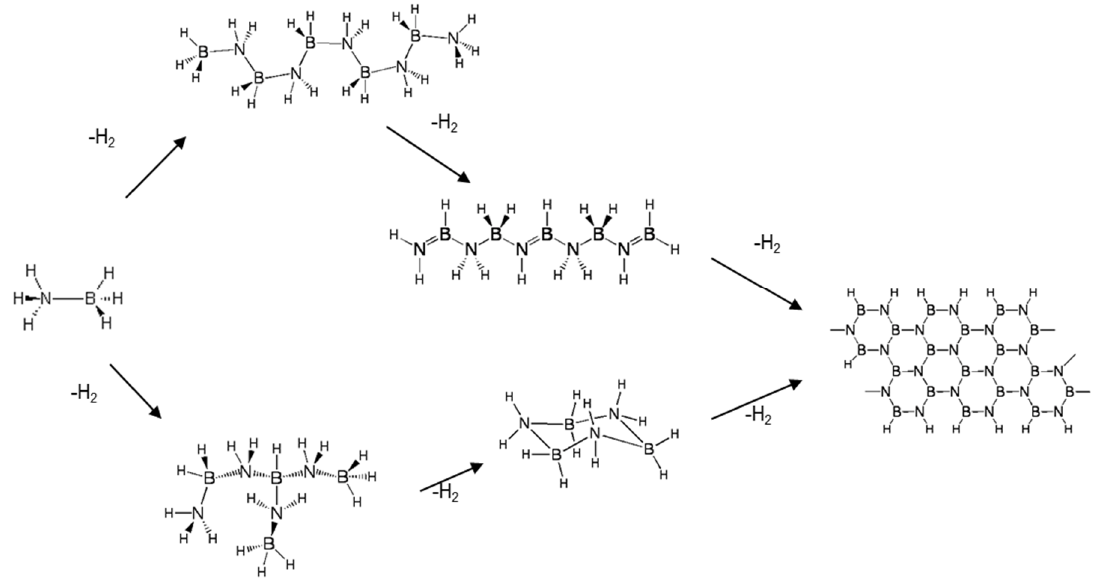
Figure 4. Reaction pathways and products observed during the thermal decomposition of solid-phase ammonia borane [3].